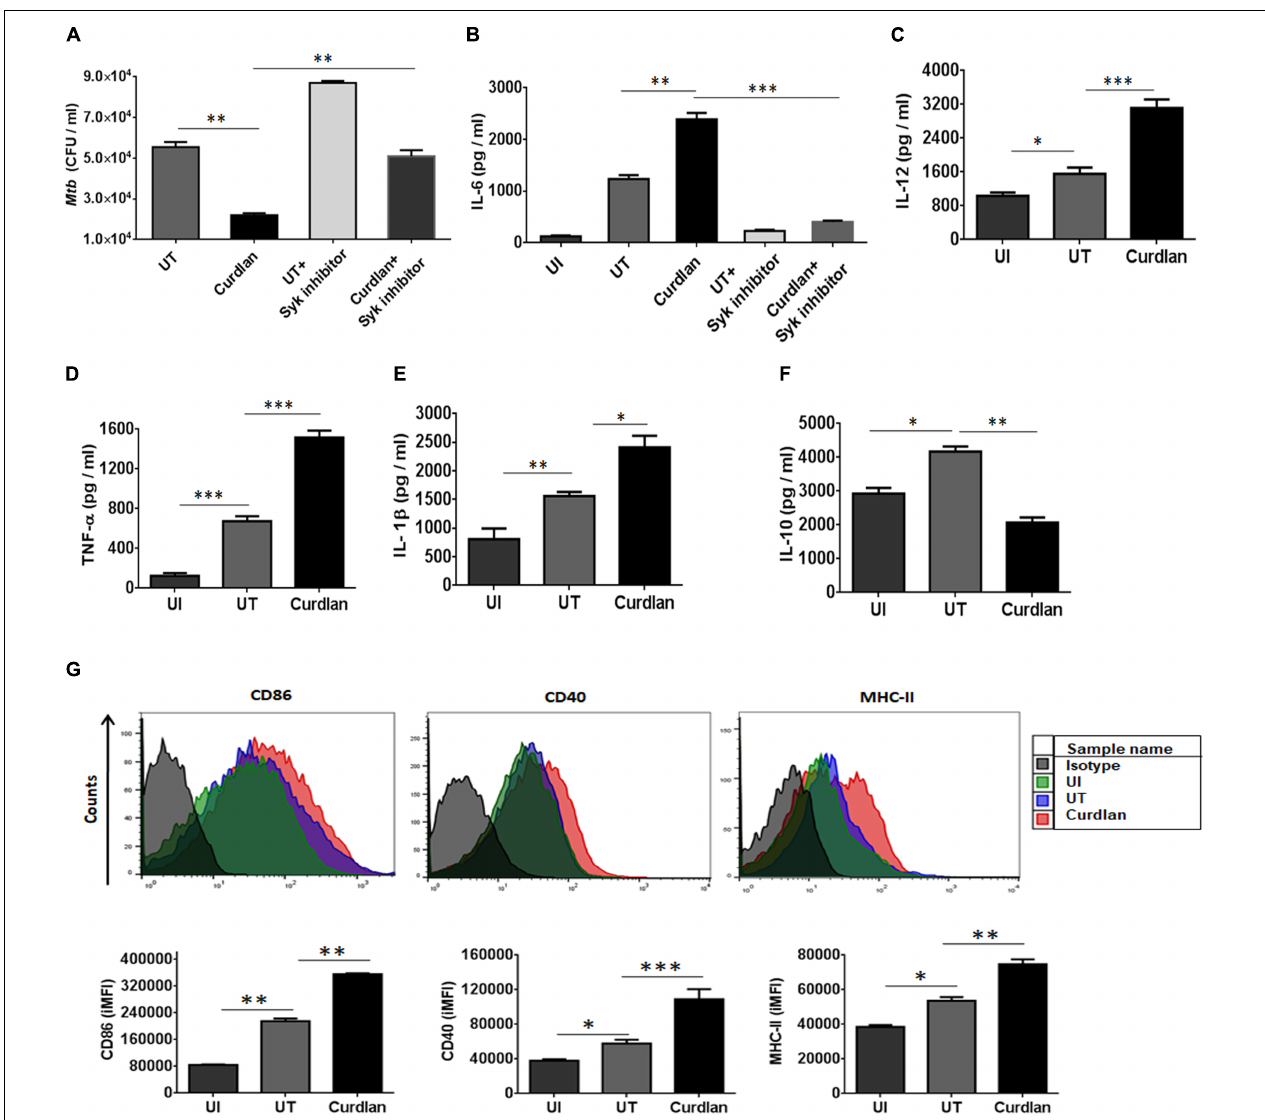
FIGURE 1 | Curdlan induces the activation and maturation of M (cid:56) s. Bone marrow-derived M (cid:56) s were infected with Mtb (at MOI of 5) and treated with curdlan (50 µ g/ml) for 48 h. (A,B) Cells were pretreated with Syk inhibitor, piceatannol (20 µ g/ml) for 45 min prior to infection. After 48 h, (A) cells were lysed and plated on the 7H11 agar plates. The Mtb CFUs were enumerated after 21 days. Further, cell culture SNs were assessed for the production of cytokines such as (B) IL-6; (C) IL-12; (D) TNF- α ; (E) IL-1 β ; and (F) IL-10 by ELISA. Additionally, (G) cells were assessed for the expression of CD86, CD40, and MHC-II with fluorescent tagged antibodies and their isotype controls. Representative flow cytometry histogram shows overlay plots and bar graphs signify integrated mean fluorescence intensity (iMFI) values. Data expressed as mean ± SD are representative from three independent experiments. ∗ p ≤ 0.05, ∗∗ p ≤ 0.01, ∗∗∗ p ≤ 0.001. UI (uninfected), M (cid:56) s not infected with Mtb ; UT (untreated), Mtb infected M (cid:56) s; Curdlan, Mtb infected M (cid:56) s stimulated with curdlan.